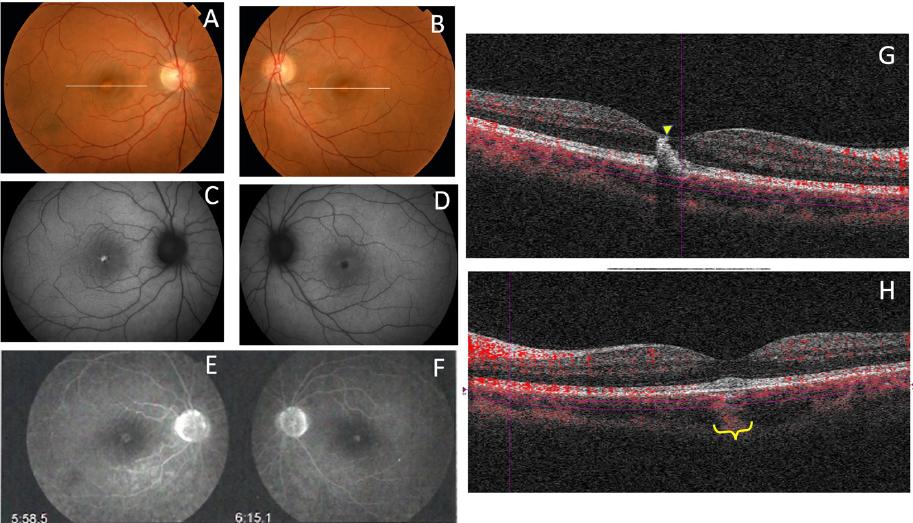
Figure 19. The clinical appearance of the case from F8-II-2 with the new mutation, c.824_828+3delinsCATTTGGGCTCCTCATTTGG. The fundus appearance of AVMD shows ( A , B ) yellow foveal deposits, which is ( C ) hyperautofluorescent in the RE and ( D ) hypofluorescent in the LE; ( E,F ) FA shows hyperfluorescence of the lesion in both eyes and ( G,H ) SD-OCT shows hyper- reflective subfoveal deposits bilaterally that ( G ) extend to the inner retina of the RE (yellow arrow) and ( H ) cause choroidal hyper-reflectivity at the foveal region on the LE (yellow brace).